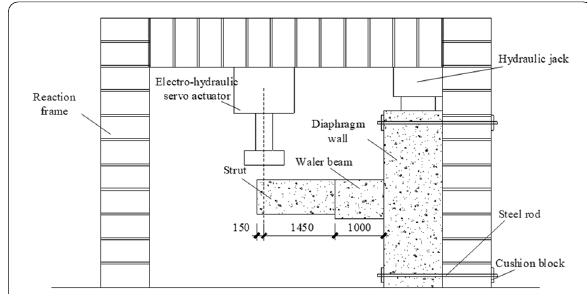
Fig. 8 Test setup (unit: